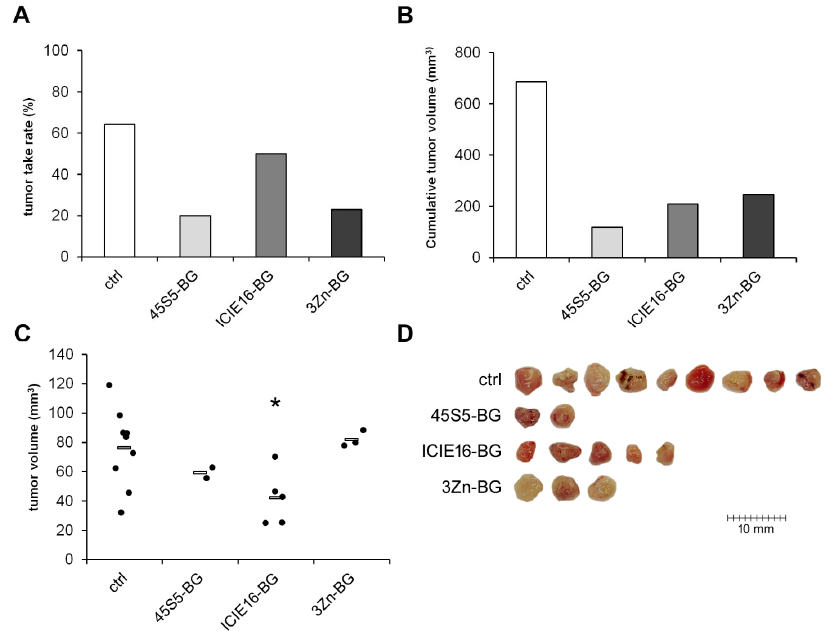
Figure 5. Effect of different BG variants on tumor formation and growth. GCTSC (1 × 10 6 per egg) were combined with 45S5-BG, ICIE16-BG, or 3Zn-BG at a concentration of 25 mg/mL and transplanted onto the CAM of fertilized chicken eggs ( n ≥ 20 per experimental group). After seven days, tumors that had formed were resected, and ( A ) the tumor take rate, ( B ) the cumulative tumor volumes, and ( C ) the individual tumor volumes ( C ) were calculated. ( D ) Photographs of the resected tumors (* p < 0.05 compared to the control group without BG).